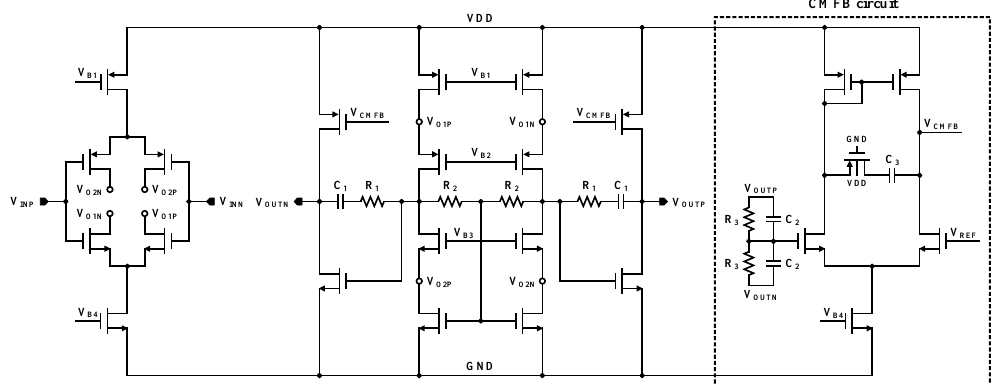
Figure 7. Schematic of the proposed fully differential amplifier.